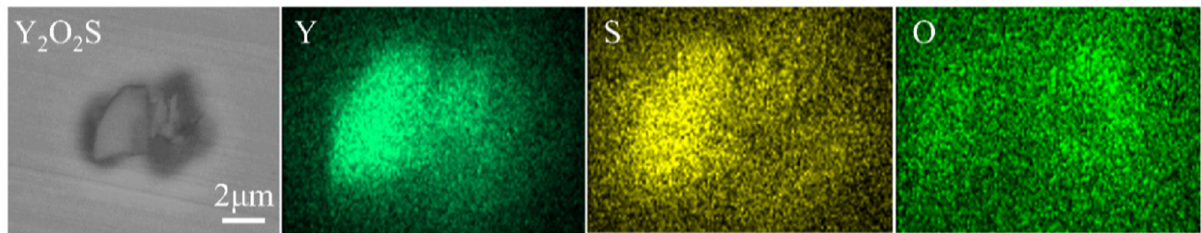
Figure 4: Element distribution of Y 2 O 2 S in hot - rolled Y - bearing steel.